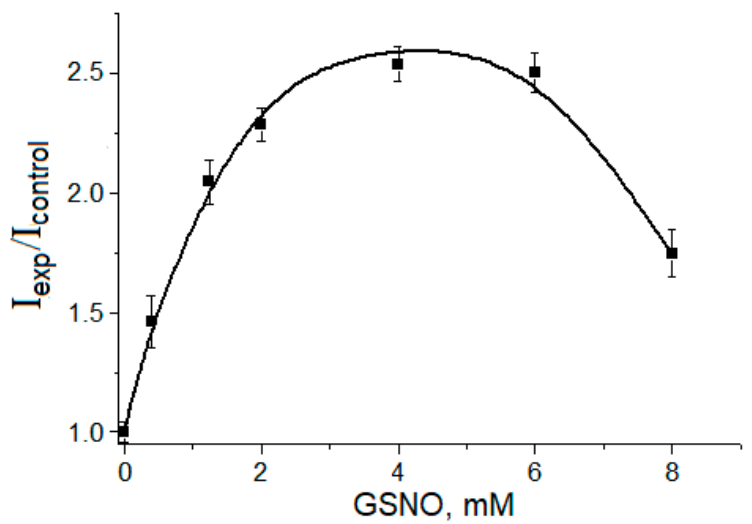
Figure 5. Levels of MG anion radicals and dialkylimine cation radicals depending on GSNO concentration. Reaction mixture: 0.2 M K,Na-phosphate buffer (pH 8.0), 160 mM lysine, 160 mM MG and GSNO. Incubation with constant nitrogen purging. EPR signals were recorded 8.5 min after mixing the components. I exp /I control —the ratio of the EPR signal intensity in the samples with GSNO to the signal in the control sample (without GSNO).